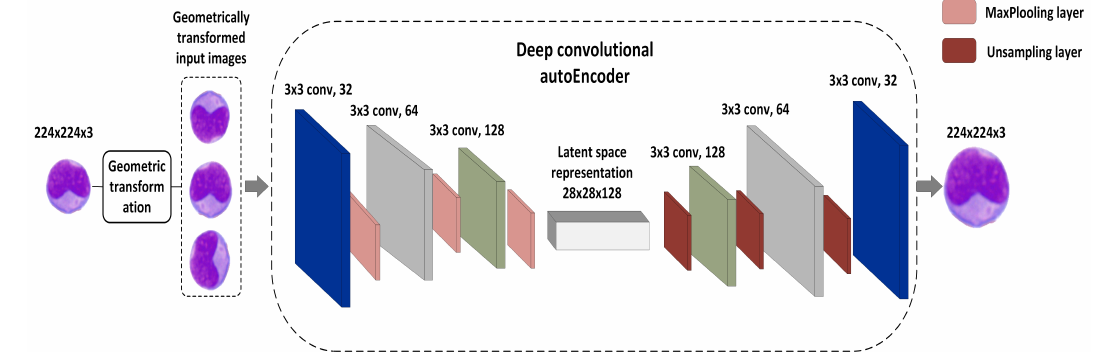
Figure 3. The GT-DCAE augmentation